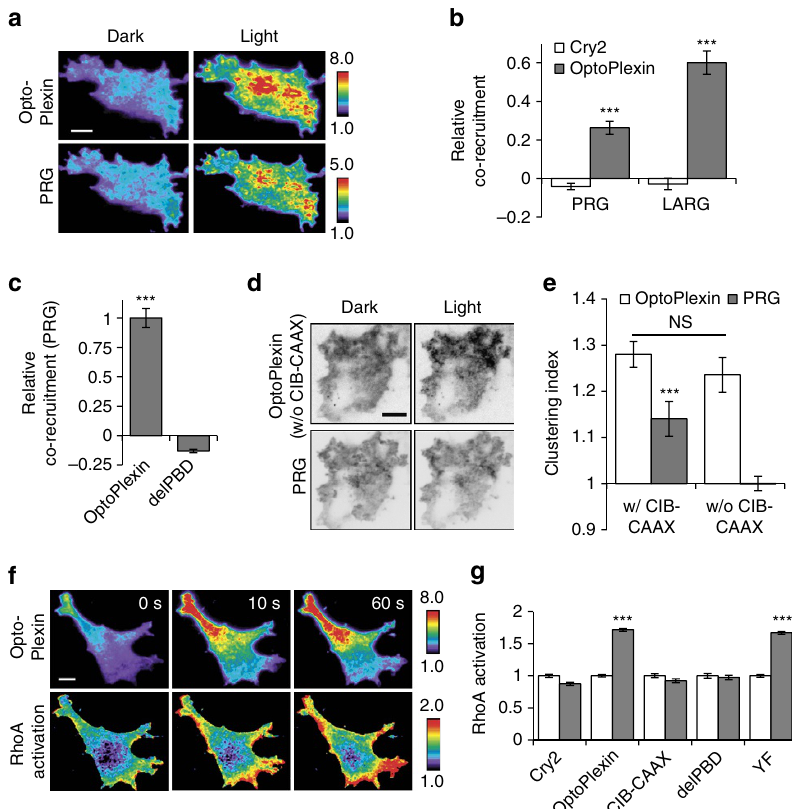
Figure 3 | OptoPlexin activates RhoA through membrane recruitment of RhoGEFs. ( a ) TIRF images showing the membrane recruitment of mVenus-PRG along with mCherry-optoPlexin after one minute of whole cell illumination in COS-7 cells. Scale bar, 10 m m. ( b ) Relative co-recruitment of mVenus-PRG or LARG by Cry2 and optoPlexin upon whole-cell illumination in COS-7 cells, n ¼ 13–19. ( c ) Normalized relative co-recruitment of mVenus-PRG by optoPlexin ( n ¼ 19) and optoPlexin-delPBD ( n ¼ 13). ( d ) TIRF images showing clustering of optoPlexin and lack of that with mVenus-PRG, in the absence of CIB-CAAX after 1min of whole-cell illumination in COS-7 cells. Scale bar, 10 m m. ( e ) Quantification of clustering of optoPlexin and PRG in the presence ( n ¼ 19) or absence of CIB-CAAX ( n ¼ 13). ( f ) Induction of mCherry-optoPlexin upon ratiometric imaging of DORA-RhoA biosensor using TIRFM. Scale bar, 10 m m. ( g ) RhoA activation in COS-7 cells expressing Cry2, optoPlexin, optoPlexin-delPBD or optoPlexin-YF upon whole-cell illumination, n ¼ 18–32 cells. For b , c , e , g , means ± s.e.m. are shown.*** P o 0.001 and * P o 0.05, NS, not significant, Student’s t